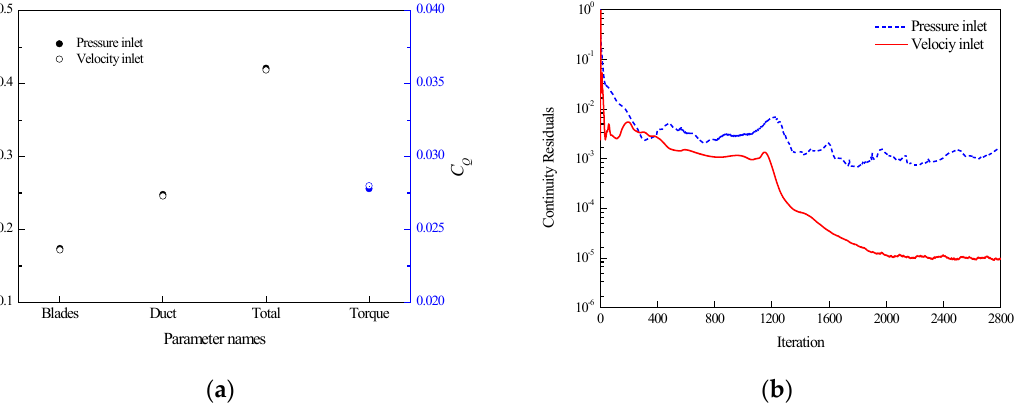
Figure 4. Computational domain and boundary conditions when out of ground effect: ( a ) boundary conditions; ( b ) computational domain divisions.